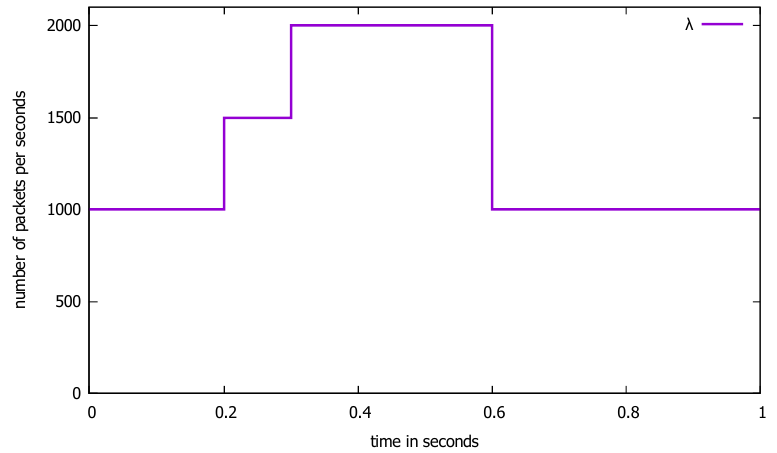
Figure 22. The input flow λ (packets per second) to the SDN switch, considered interval of 1